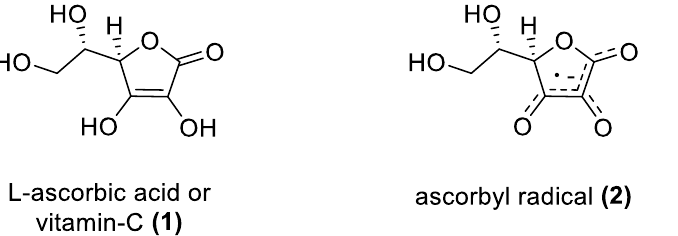
Figure 2. Structure of ascorbic acid and the ascorbyl radical depicting resonance stabilization.